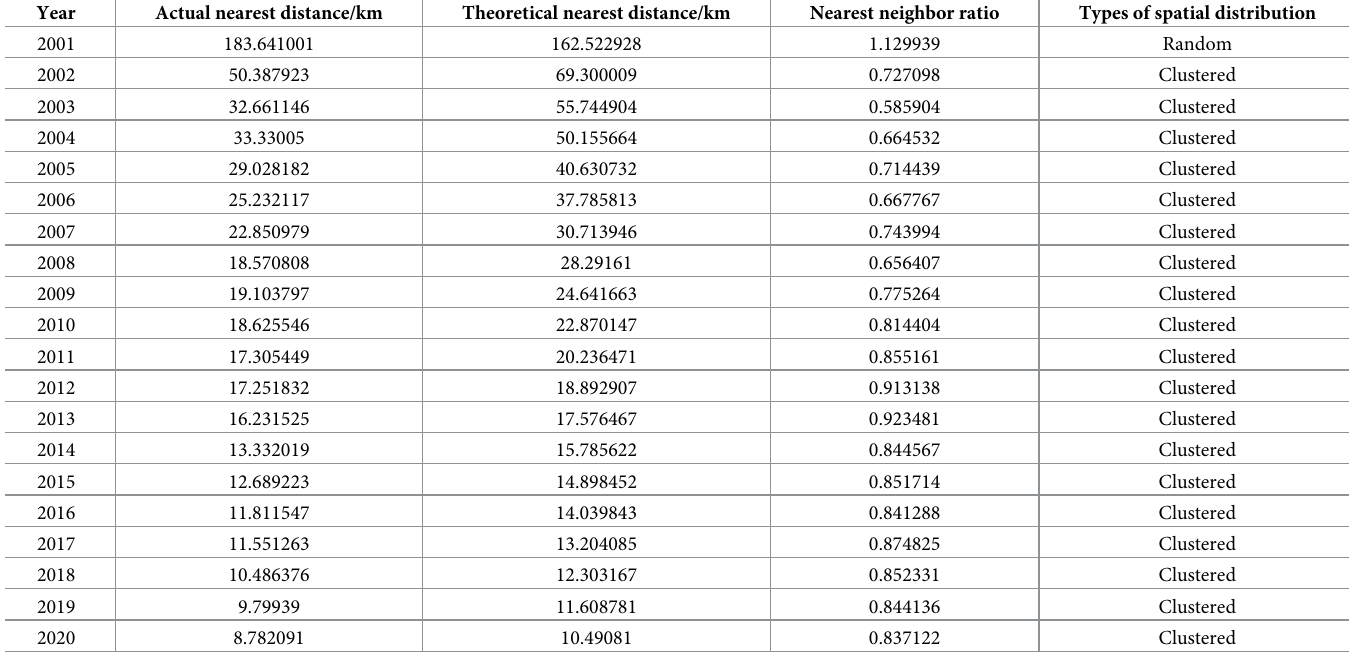
Table 1. Nearest neighbor analysis of spatial distribution of A-level scenic spots in Guangdong